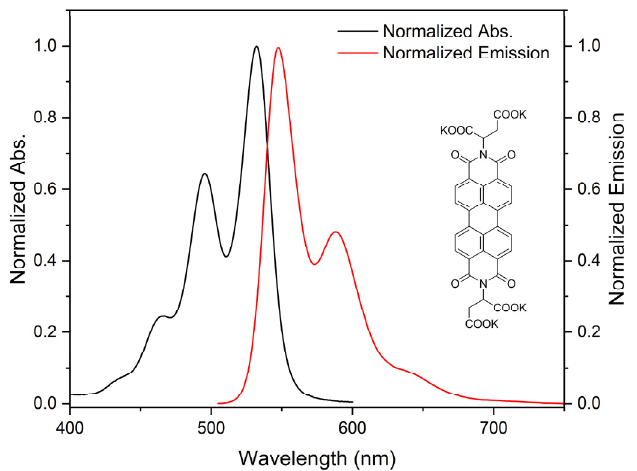
Figure 1. Normalized absorption and emission spectra of APBI-K in water. Inset: Chemical structure of APBI-K molecule.